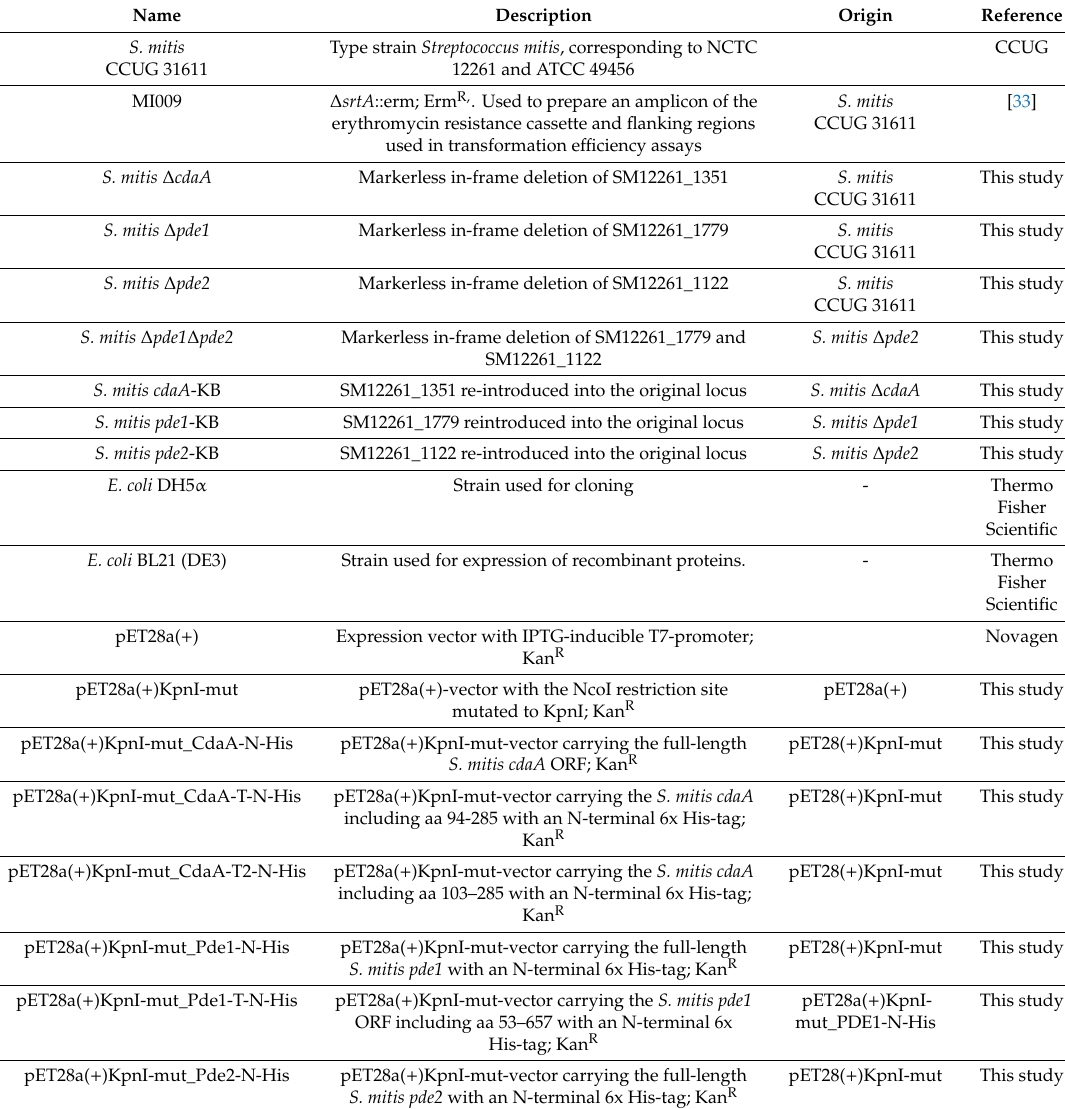
Table 1. Strains, mutants and plasmids used in this